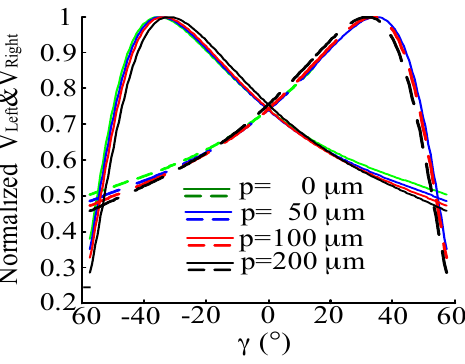
Figure 9. Normalized characteristic curve of V Right and V Left when γ changes. ( p is 0 μ m, 50 μ m, 100 μ m and 200 μ m, respectively, α is 20°, h is 500 μ m).